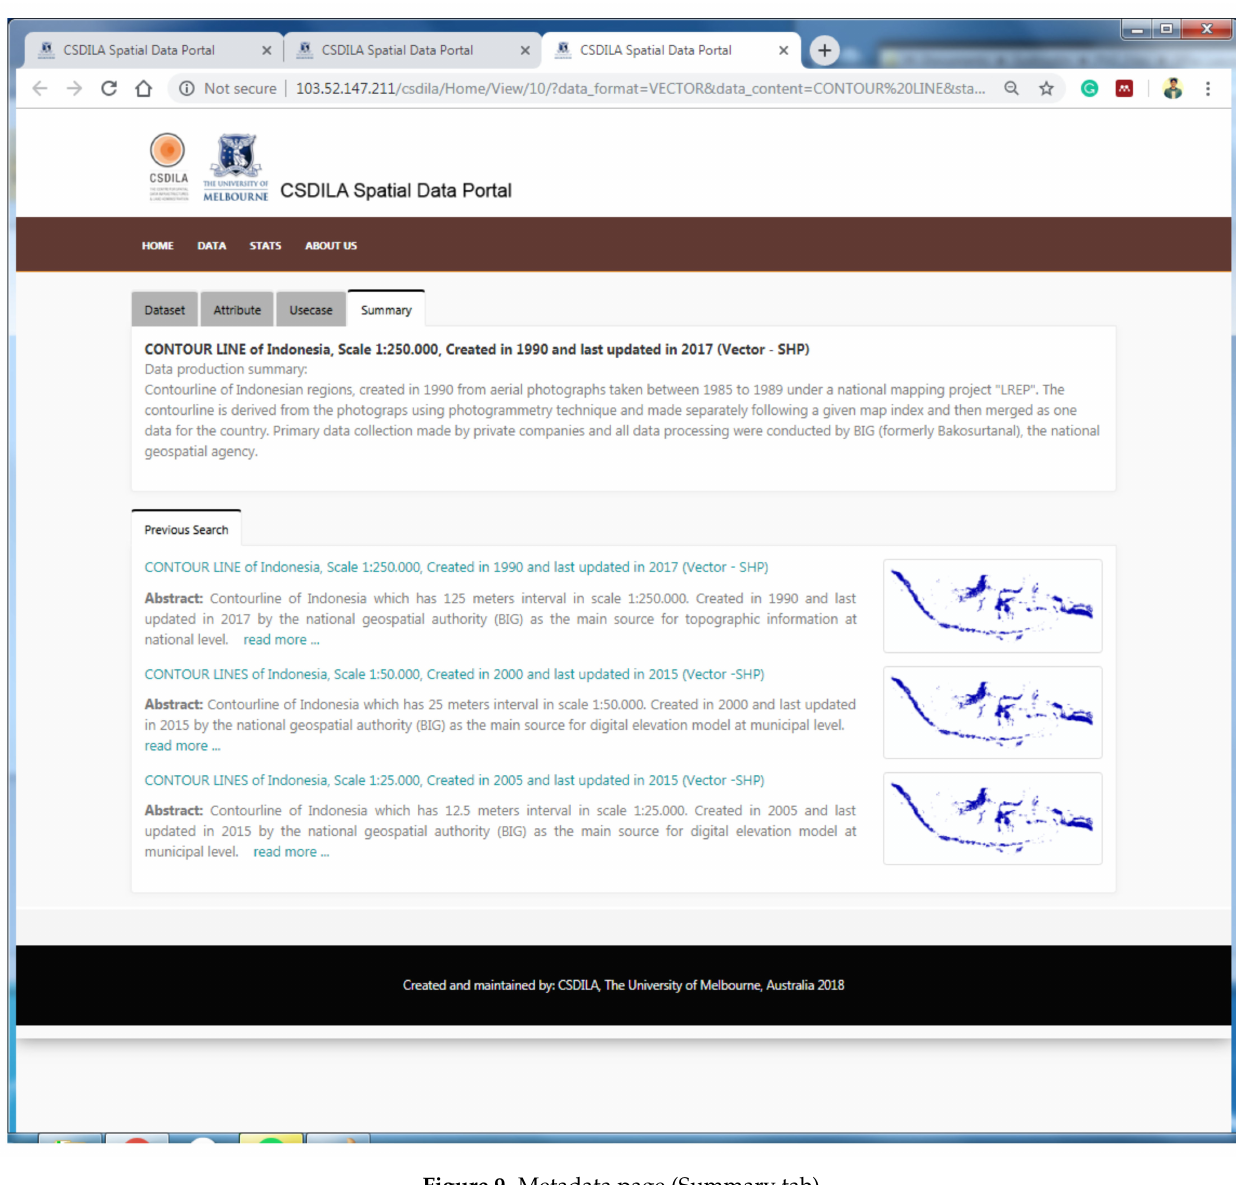
Figure 9. Metadata page (Summary